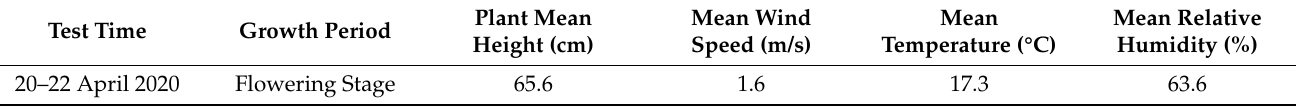
Table 1. The wheat characteristics and weather conditions.